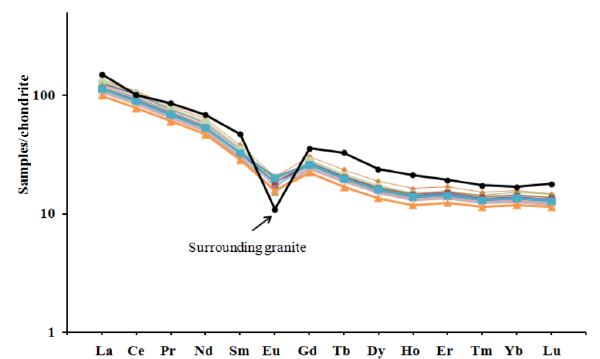
Figure 5. REE distribution patterns (normalised by chondrite) of pilot samples from the Datang profile and samples of the surround- ing granite (average values of eight samples; Shu et al.,